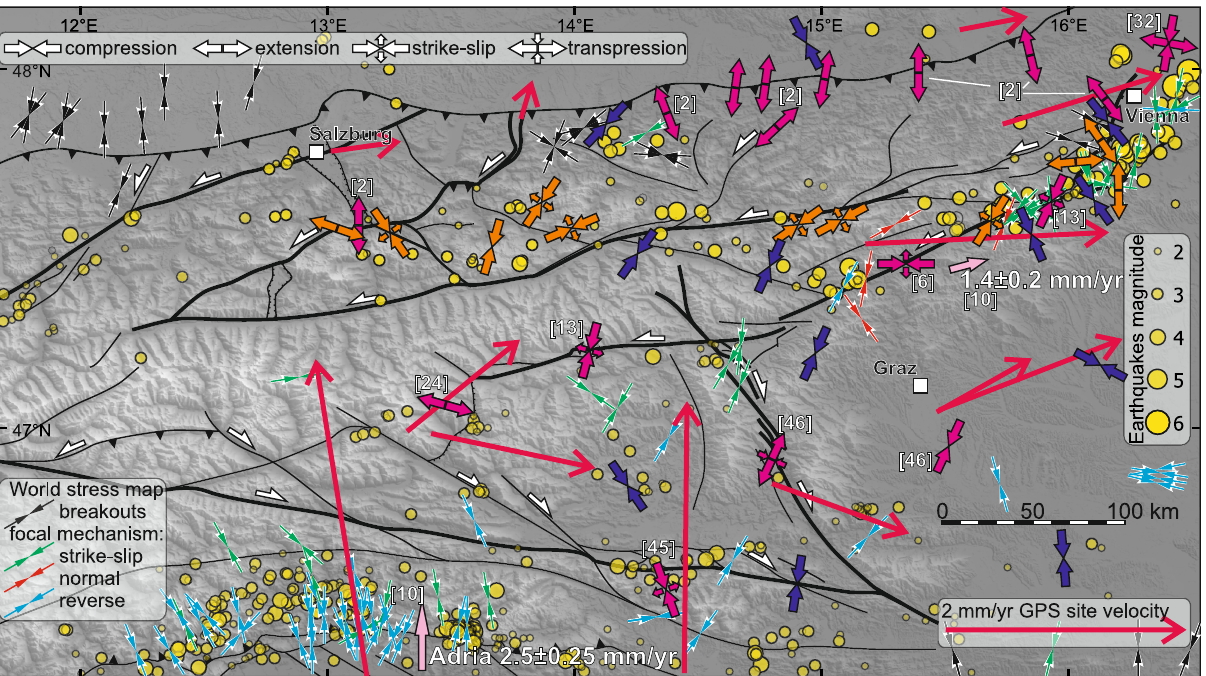
Figure 5. Major fault systems in the Eastern Alps [after 1, 2, 6] imposed on Shuttle Radar Topography Mission (SRTM) 1 arc-second shaded relief with digital elevation model (https:// www2. jpl. nasa. gov/ srtm/; CC BY 4.0 ) with: Pliocene–Pleistocene paleostress data (orange arrows—this research, purple arrows—previously published data, numbers in square brackets by the arrows correspond with the references list), present-day maximum horizontal compressional stress S Hmax (dark blue arrows 8 and World Stress Map 7 ), Present-day maximum uniform principal strain axes and relative displacements (pink arrows 10 ), GPS site velocity (scaled red arrows 10 ), seismicity (01.01.2000–18.07.2022 https:// www. usgs. gov/ produ cts/ data- and- tools/ real- time- data/ earth quakes). The map layout was created in QGIS 3.22.4 (https:// www. qgis. org/ en/ site/; GNU